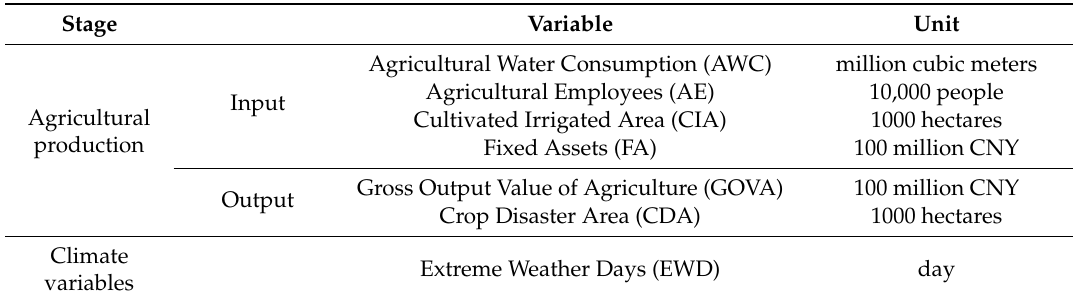
Table 2. The input and output